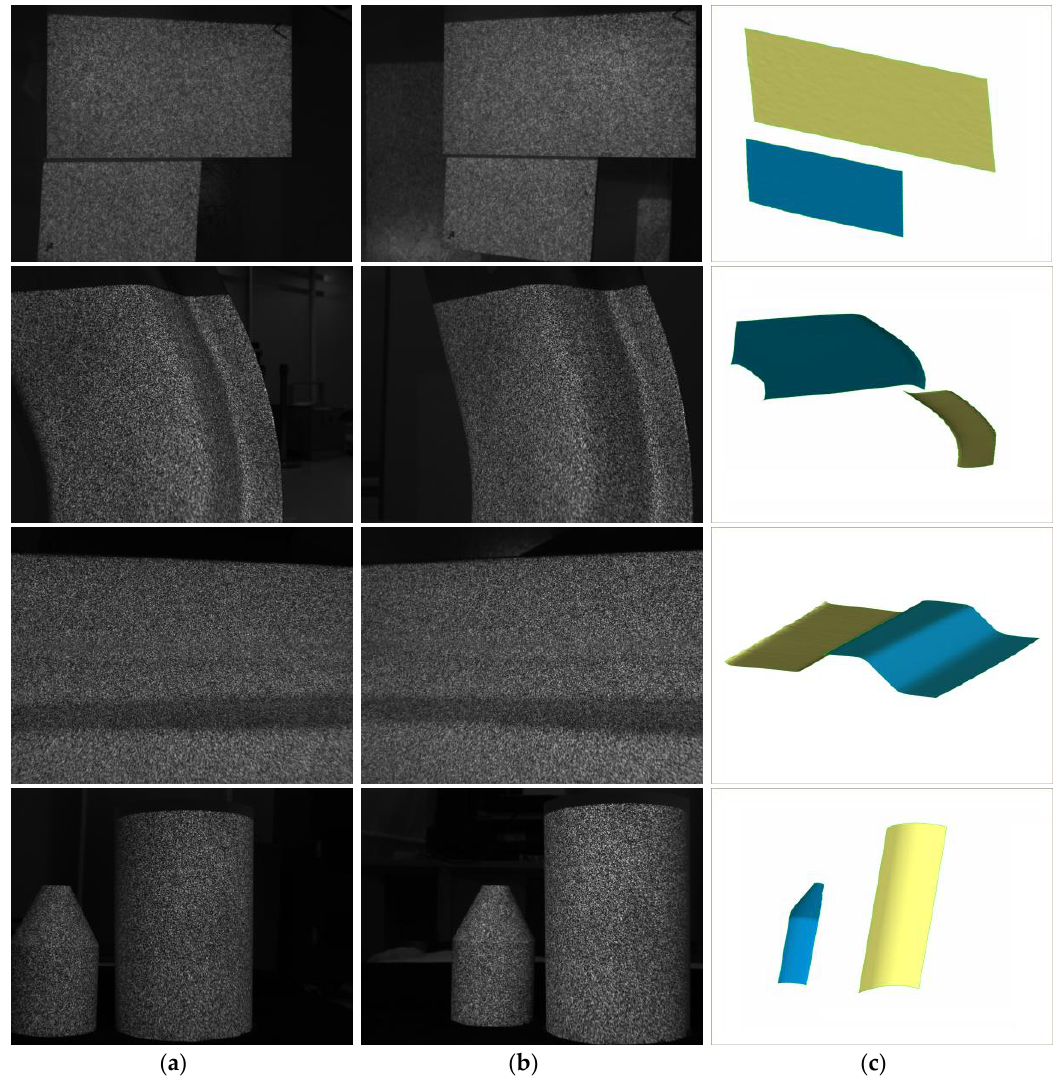
Figure 11. Real objects measurement: ( a ) left image; ( b ) right image; and ( c ) 3D shape.